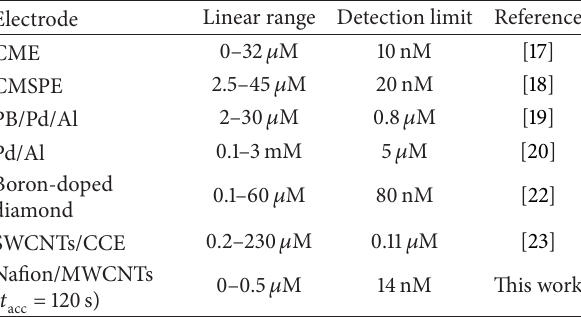
Table 2: Voltammetric detection of codeine reported at various